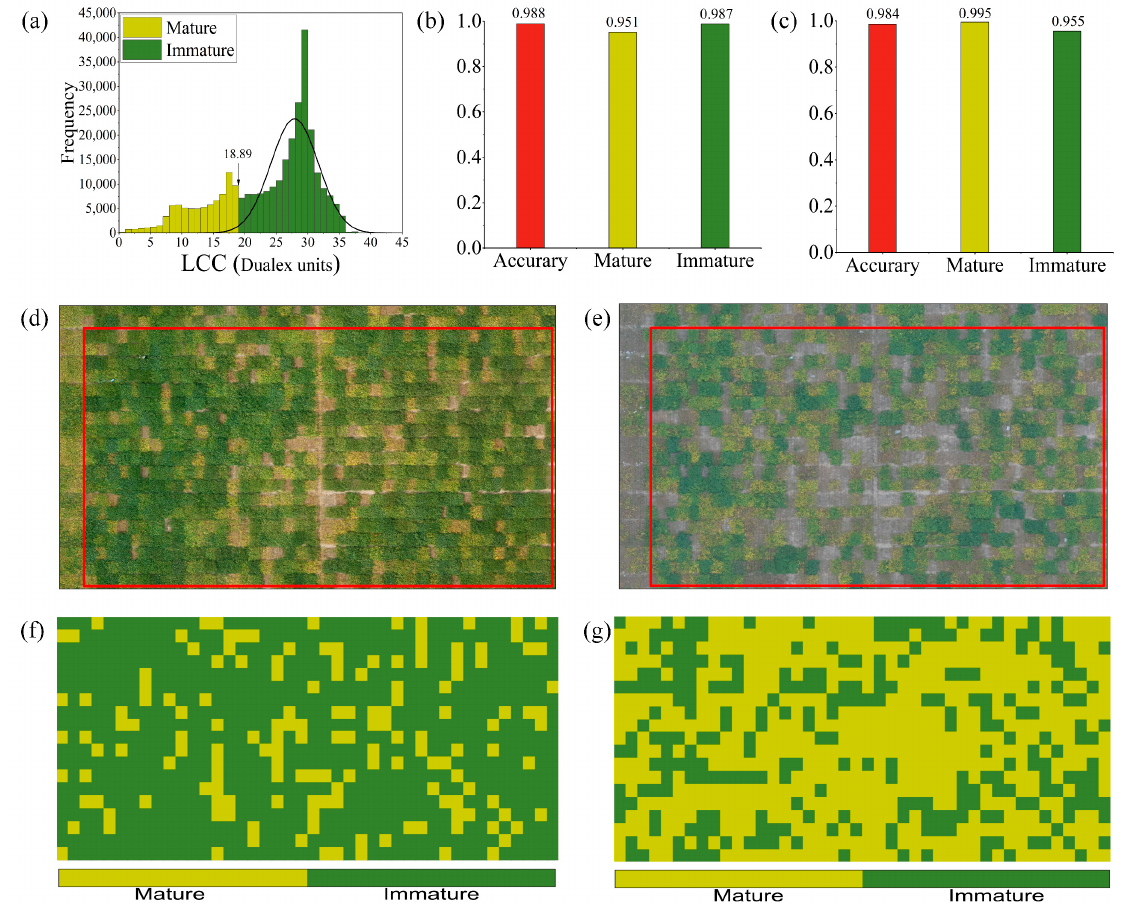
Figure 10. P3 soybean early maturity monitoring: ( a ) Histogram of P3-LCC anomaly distribution; ( b ) P3 maturity monitoring accuracy; ( c ) P4 maturity monitoring accuracy; ( d ) P3-RGB; ( e ) P4-RGB; ( f ) P3-LCC monitoring visualization results; ( g ) P4-LCC monitoring visualization results. Note: The red boxed areas in ( d , e ) are the areas used for accuracy evaluation.